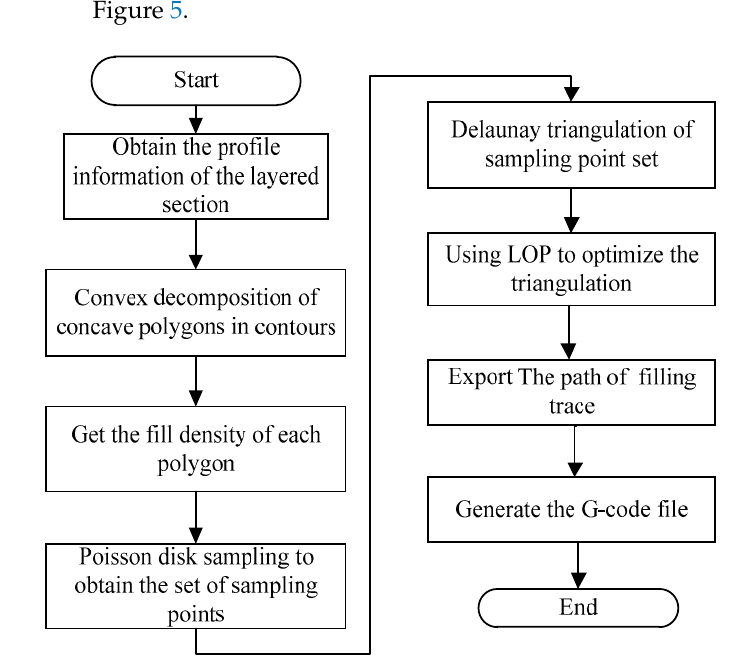
Figure 5. The flow chart of filling algorithm.